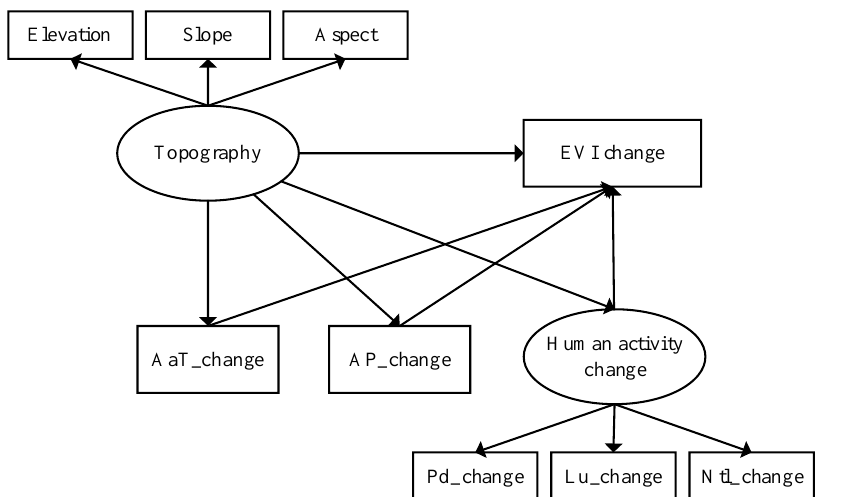
Figure 2. Conceptual structural equation model. Note: Rectangles represent observed variables, and ellipses represent latent variables. AaT_change = annual average temperature change; AP_change = annual precipitation change; Lu_change = land use change; Ntl_change = nighttime light change.